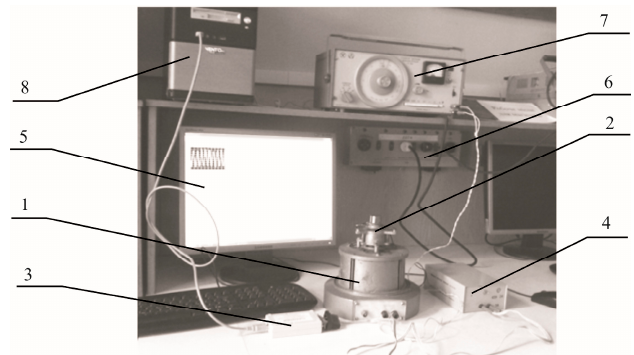
Figure 3. Appearance of the device for SE experimental investigations: 1—GMK-1; 2—SE; 3—SE